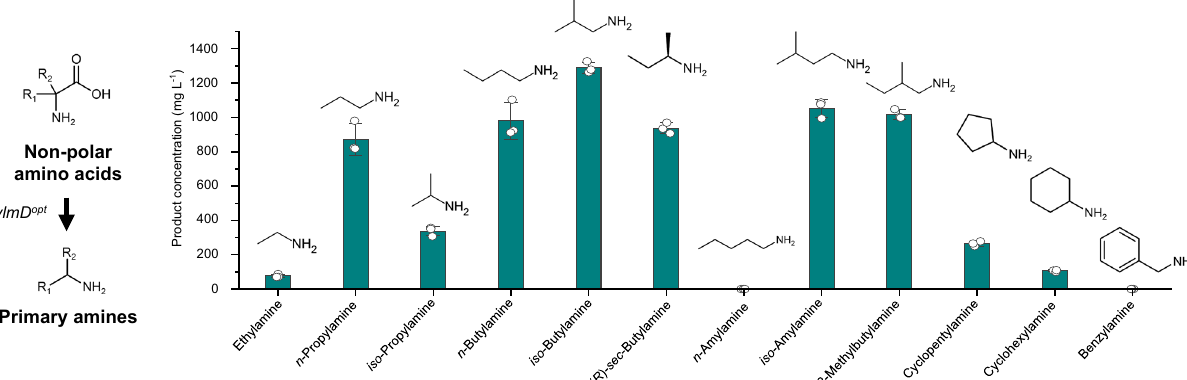
Fig. 5 In vivo production of 12 SCPAs via feeding of their direct precursors. Production titers of 12 SCPAs from E. coli expressing the codon-optimized Streptomyces viridifaciens vlmD (PA01 strain) are presented where direct precursors of the SCPAs were individually provided in the medium. All the experiments for the production of each SCPA were conducted in triplicates. Data are presented as mean values ± s.d. Source data are provided as a Source Data fi